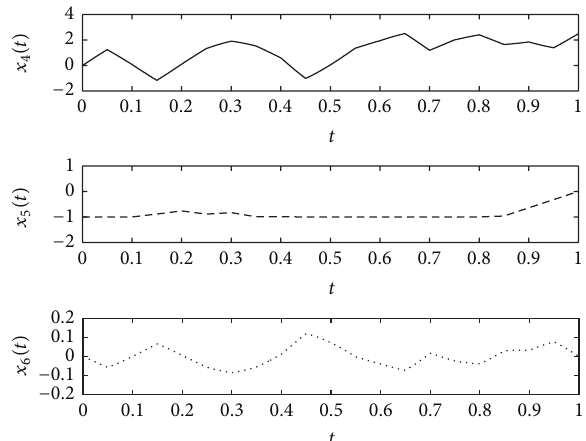
Figure 3: Optimal states under optimal controls.